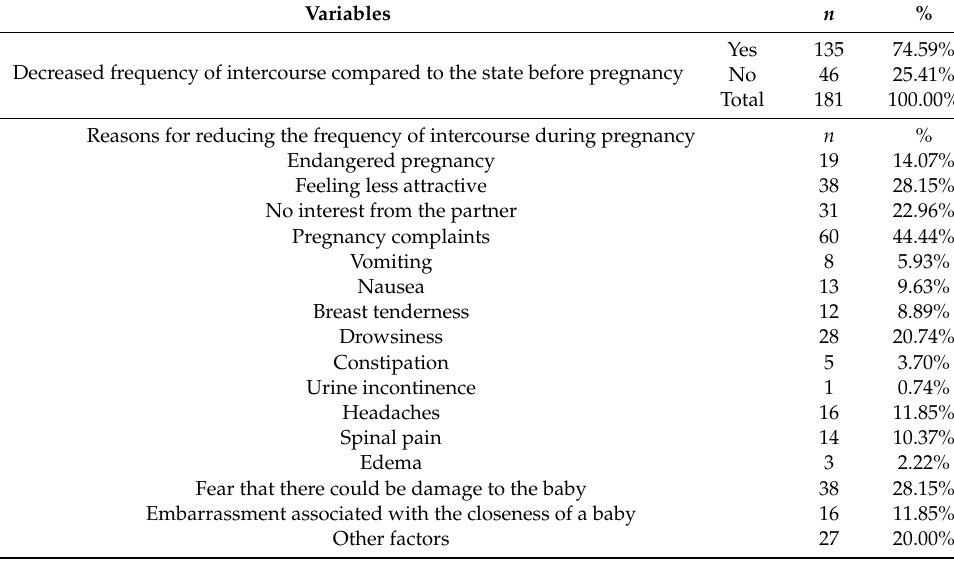
Table 10. Decreased frequency of intercourse compared to the state before pregnancy. Variables Decreased frequency of intercourse compared to the state before pregnancy